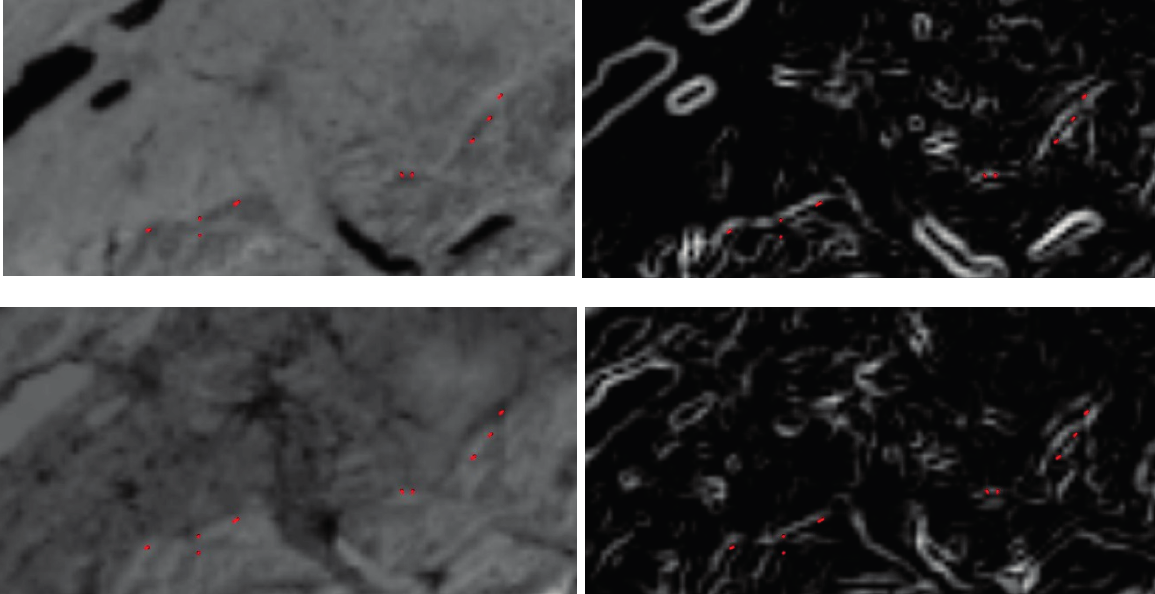
Figure 6. Parts of AVHRR Band-2 ( top ) and Band-5 ( bottom ) images acquired on 10 July 2008 at 09:36 from Metop-A. The matched points between the preprocessed images ( right ) are shown in both and presented on linear stretched images ( left ) as